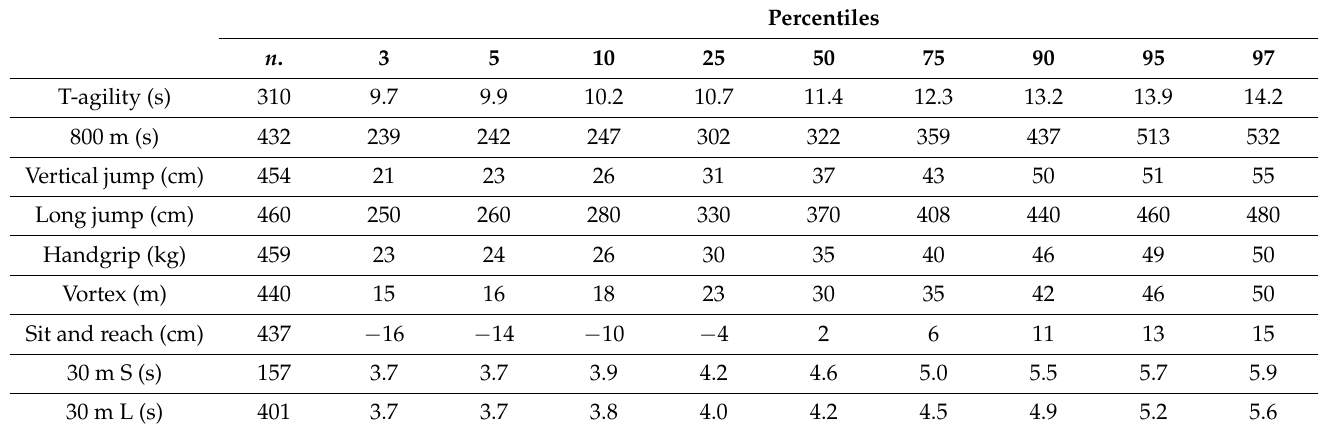
Table 3 of 14-year-old female students, Table 4 of 15-year-old female students, and Table 5 of 15-year-old female students. Table 2. Fitness test percentiles for males in the first class of the high school.